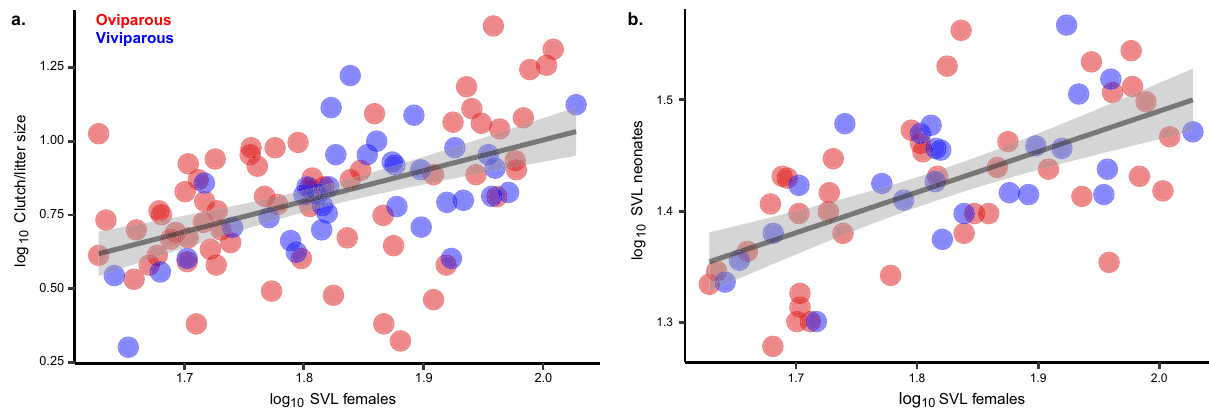
Fig. 2 Dam ’ s body size is positively correlated with clutch/litter size and neonate body size in phrynosomatid lizards. In fl uence of dam ’ s body size on clutch/litter size ( a ; y = 1.1321x − 1.2362, two-sided P < 0.001, n = 64 oviparous species and 36 viviparous species) and on the body size of neonates ( b ; y = 0.2893x + 0.9064, two-sided P < 0.001, n = 39 oviparous species and 25 viviparous species). Data are presented as mean values, and regression lines are wrapped by 95% con fi dence bands. The regression slopes were estimated by phylogenetic regressions (PGLS), and the source data are provided as a Source Data fi